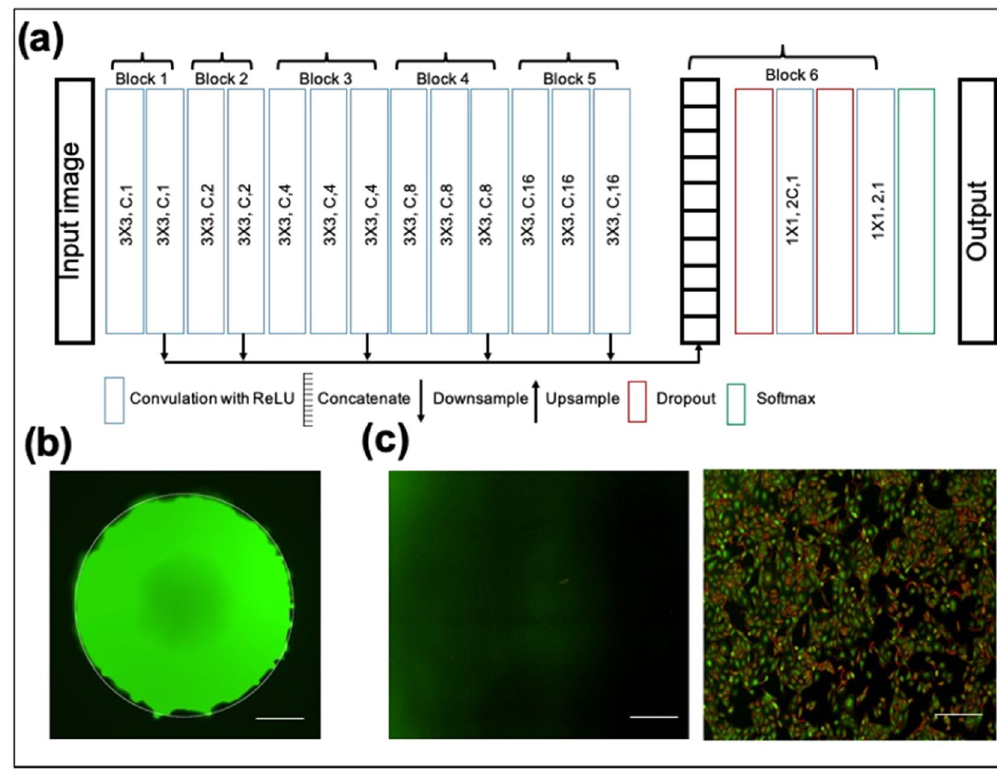
Figure 2. ( a ) Architecture of P-Net, ( b ) Segmentation of MCSs using P-Net and ( c ) control- without fluorescence (left panel) and calcein-AM uptake by 2D cultures (right panel). Scale bar, 200 μ